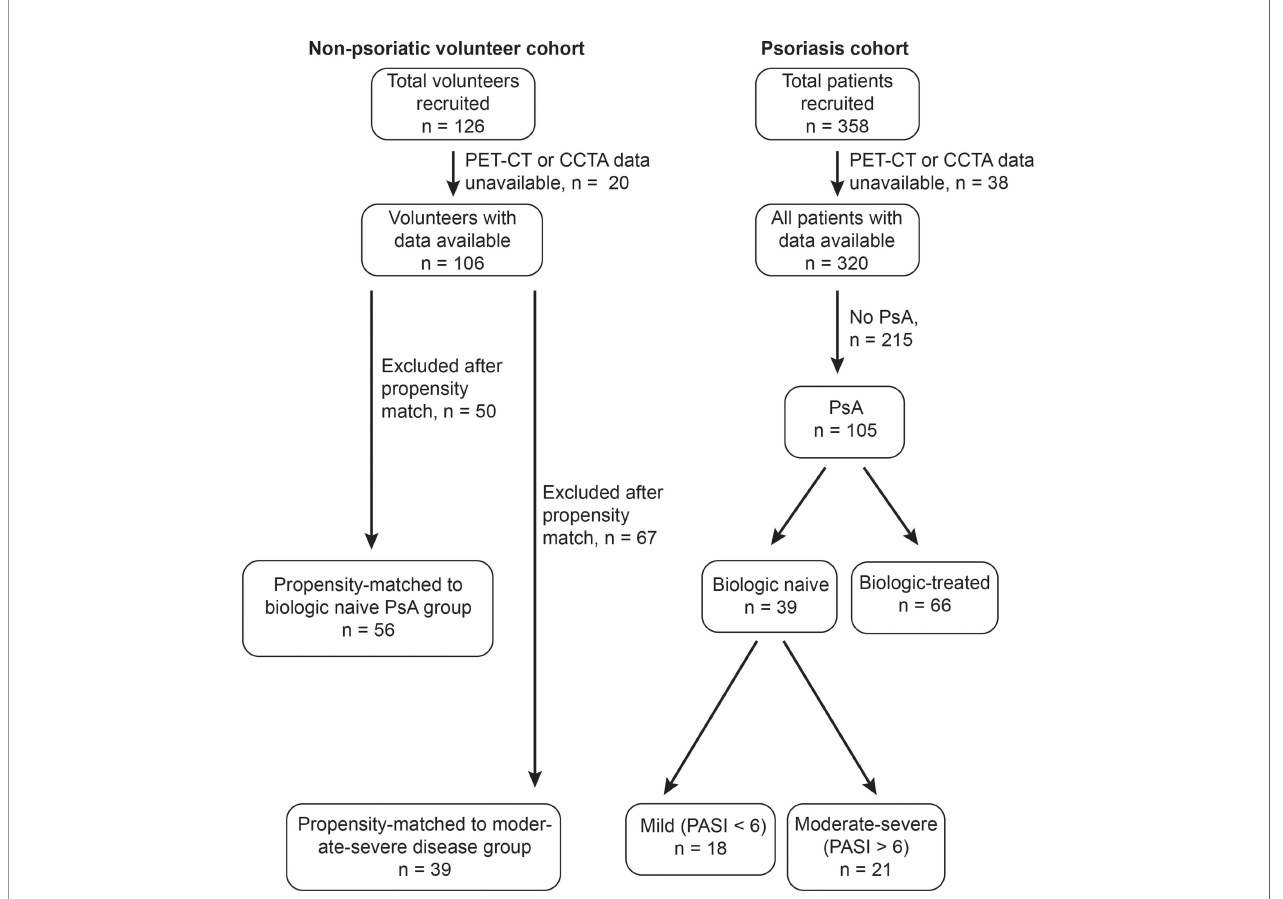
FIGURE 1 | Identi fi cation of subjects with treatment-naive psoriatic arthritis (PsA) within a cohort of patients with psoriatic diseases, and of age-sex-matched non- psoriatic volunteers. 358 total patients with psoriatic diseases were recruited, of whom 320 were con fi rmed to have psoriatic disease and had PET-CT and CCTA data available. Of these 105 had psoriatic arthritis, 39 of whom were biologic-naive. 21 biologic naive patients with PsA had moderate-severe skin disease. 126 total non-psoriatic volunteers were recruited, of whom 106 had PET-CT and CCTA data available. 56 volunteers were age-sex-matched to the full treatment-naïve PsA cohort, whereas 39 volunteers were age-sex-matched to the 21 subjects with moderate-severe skin